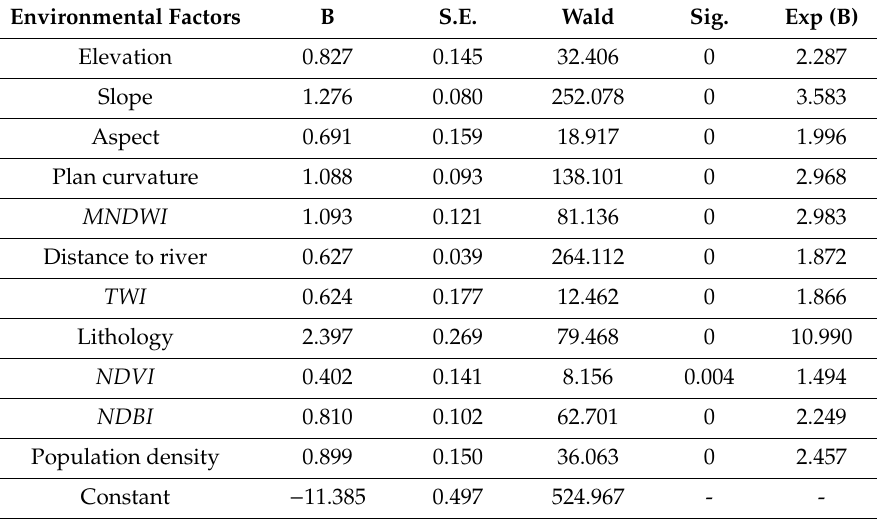
Table 2. The parameters in the LR